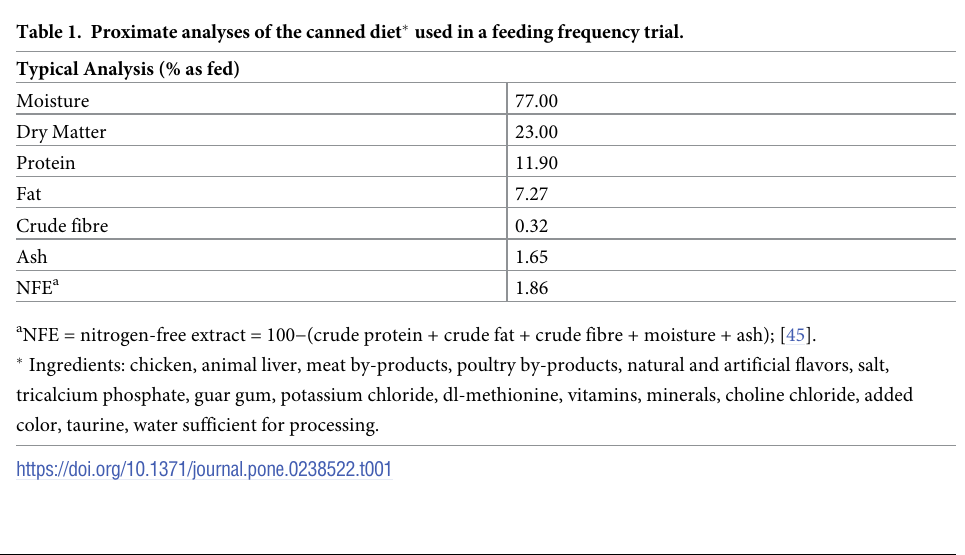
Table 1. Proximate analyses of the canned diet � used in a feeding frequency trial. Typical Analysis (% as fed)